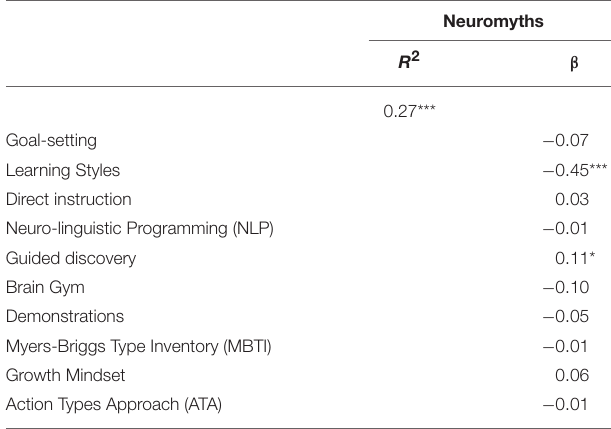
TABLE 6 | Multiple regression predicting neuromyths from use of learning-based and brain-based